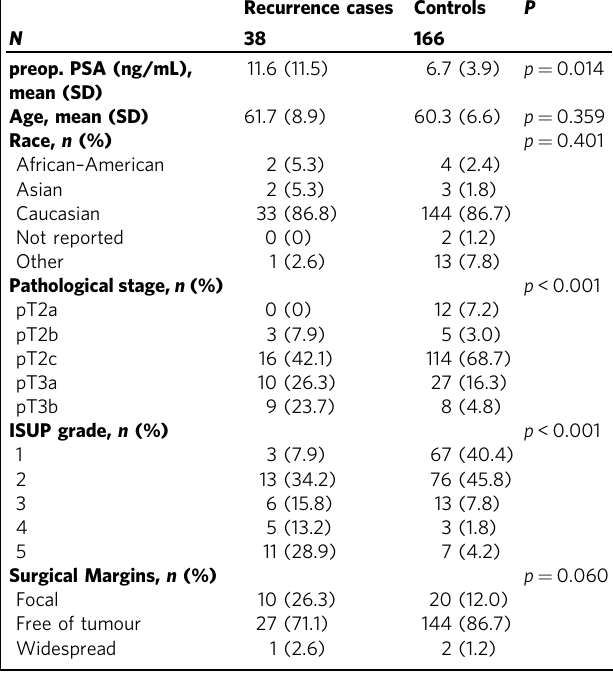
Table 2 Baseline characteristics of the cohort from New York Langone hospital, prostate cancer recurrence cases and controls, men who underwent radical prostatectomy between 2001 and 2003.